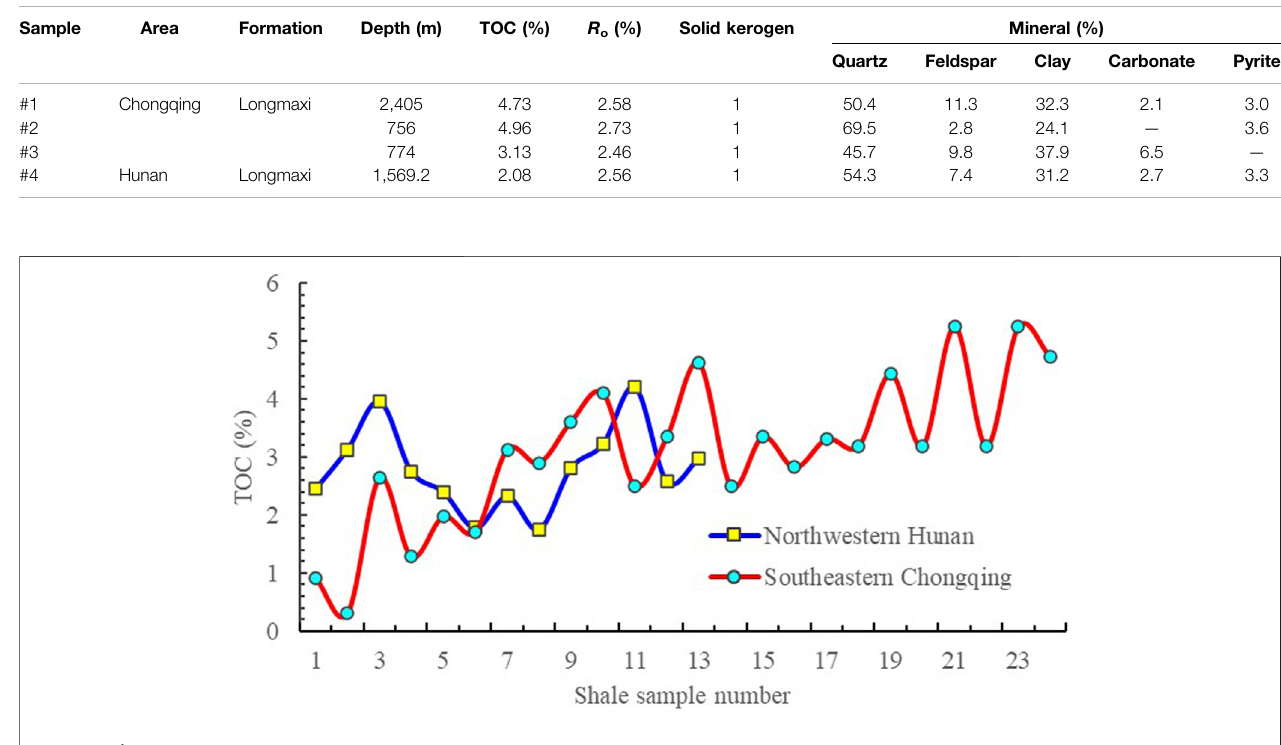
( Figure 4 ). TOC content average value of Hunan samples is 3.1%, and the highest TOC content value reaches 4.5%